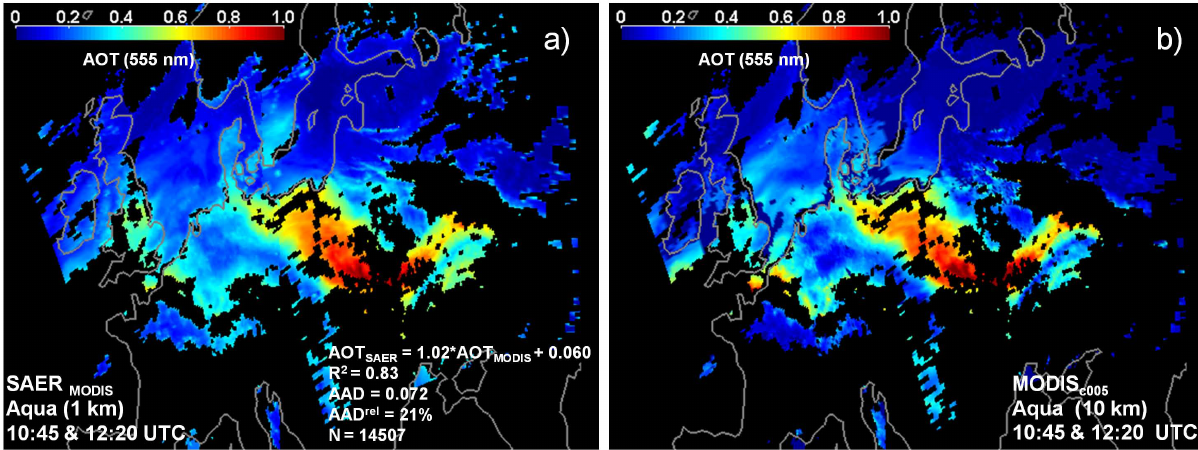
Fig. 3. Aqua satellite scenes of AOT at 555nm over land and water surfaces in Europe for a combination of two overpasses at 10:45 and 12:20UTC on 1 April 2007 obtained with (a) the SAER algorithm and (b) the MODIS c005 algorithm. The expression for the linear regression curve was calculated based only on co-located land pixels and without binning the data. The explanation of abbreviations is given in Sect.